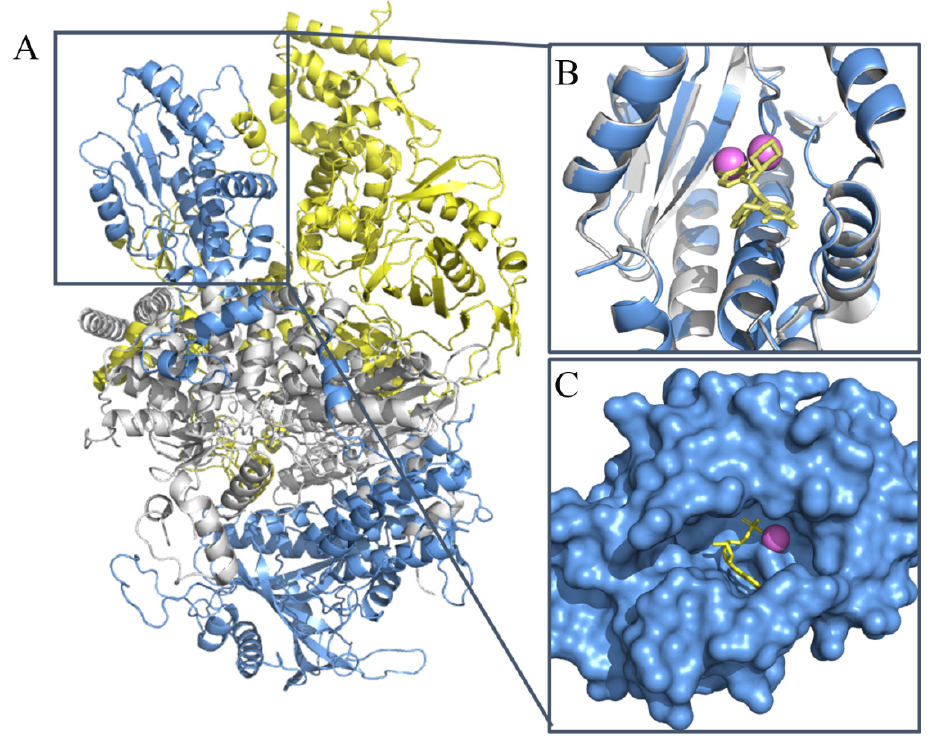
Figure 1. The structure of PA endonuclease. ( A ) The structure of RNA-dependent RNA polymerase (influenza A virus H5N1, PDB ID: 6QPF). The PA domain is shown in blue. The PB1 domain is shown in white. The PB2 domain is shown in yellow. ( B ) The cartoon structure of PA N-terminal (blue) (PDB ID: 6FS6) or PA-I38T N-terminal (white) (PDB ID: 6FS7) endonuclease domain complex with the inhibitor BXM. The BXM is shown in yellow. The Mn2+ is indicated with violet spheres. ( C ) The PA active site pocket complex with the substrate Amp. Amp is shown in yellow. The Mn2+ is indicated with violet